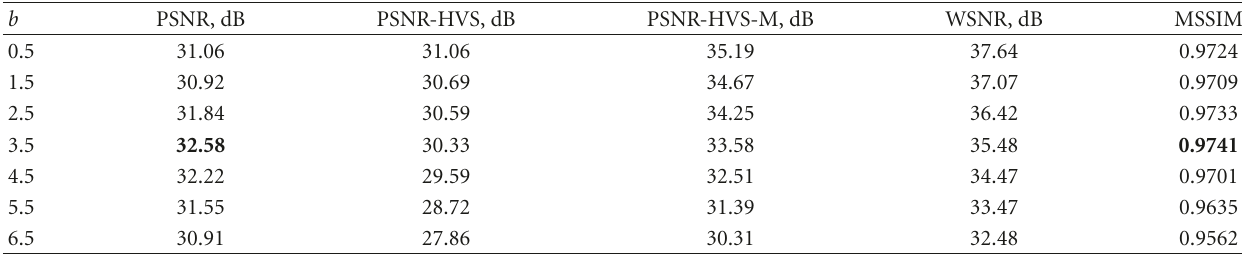
Table 2: Metrics Dependencies on b for the image Goldhill, σ 2 = 50, coder